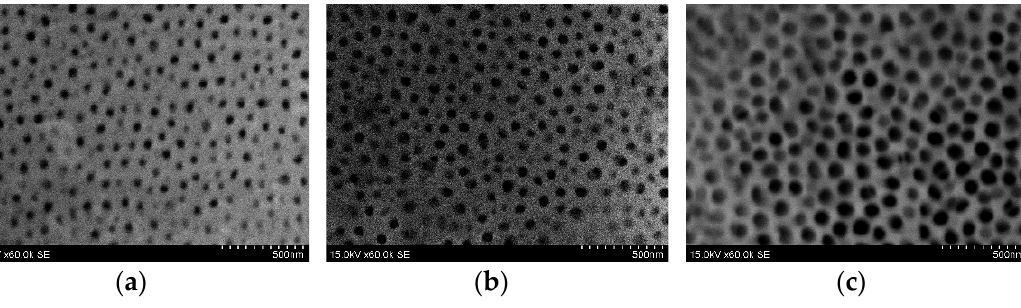
Figure 6. SEM images of AAO nanoporous membrane. ( a ) AAO nanoporous membrane after the two-step anodization process; ( b ) AAO nanoporous membrane after the two-step anodization pro- cess using 3.1 kHz frequency excitation; ( c ) AAO nanoporous membrane after the two-step anodiza- tion process using 4.1 kHz frequency excitation.